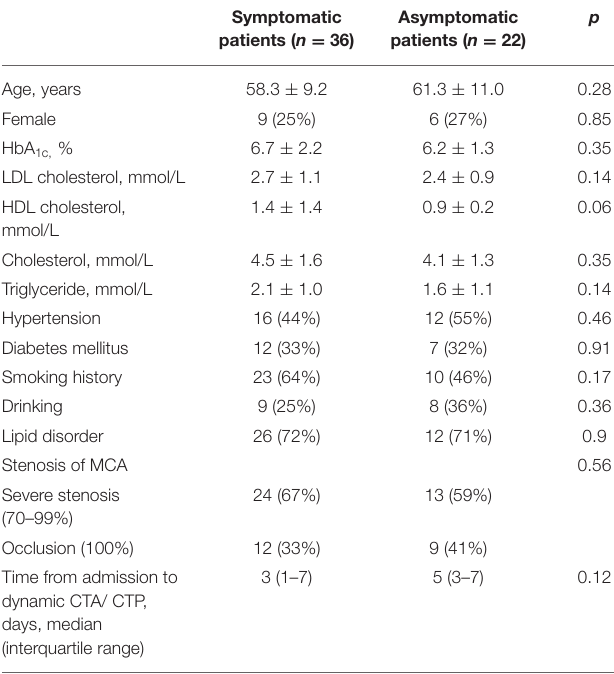
TABLE 1 | Baseline demographics of symptomatic and asymptomatic patients. Symptomatic Asymptomatic patients ( n = 36) patients ( n =